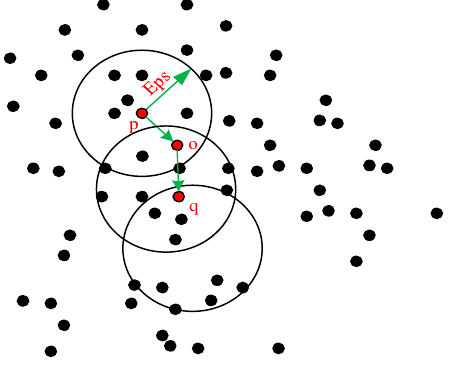
Figure 3. Definition of density-reachable.